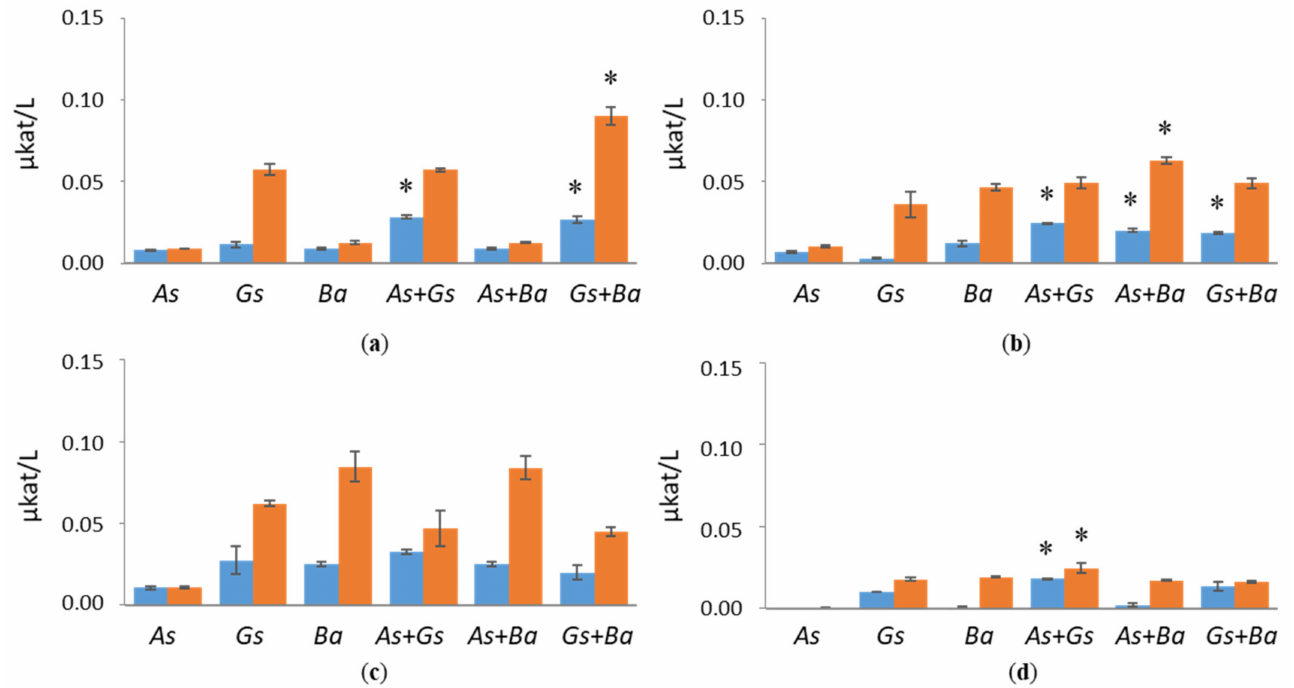
Figure 2. β -glucosidase (BGL) activities at early (day 10, marked in blue) and late time points (day 24, marked in red) in single and co-cultivation on ( a ) birch, ( b ) spruce, ( c ) pine wood and ( d ) Avicel. As = A. sinuosa , Gs = G. sepiarium , Ba = B. adusta , As + Gs = A. sinuosa and G. sepiarium , As + Ba = A. sinuosa and B. adusta , Gs+Ba = G. sepiarium and B. adusta . Error bars refer to standard deviation (SD) ( n = 3). * indicates statistical difference among single and co-cultivations ( p <